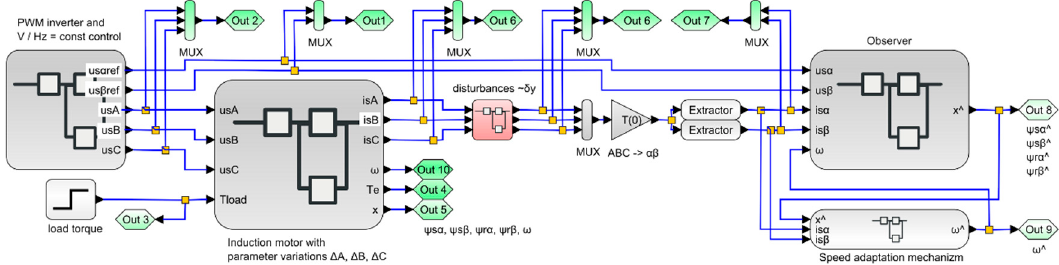
Figure 5. Simulation model in Scilab-Xcos environment, simplified version. For full simulation model refer to attached file sim model.zcos.